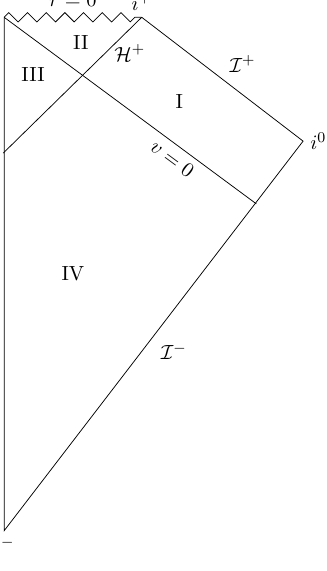
Figure 2 . Conformal diagram for Vaidya